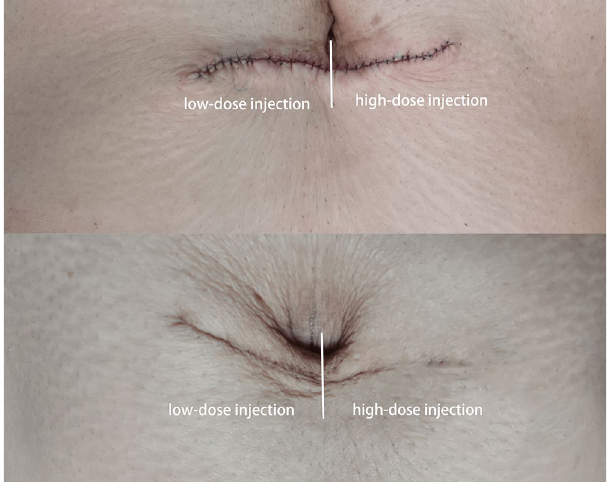
Figure 3. Abdominal scar at baseline ( above ) and at 6-month follow-up ( below ). The right half of the scar was treated with high-dose botulinum toxin type A (BTxA) and the left half was treated with low-dose